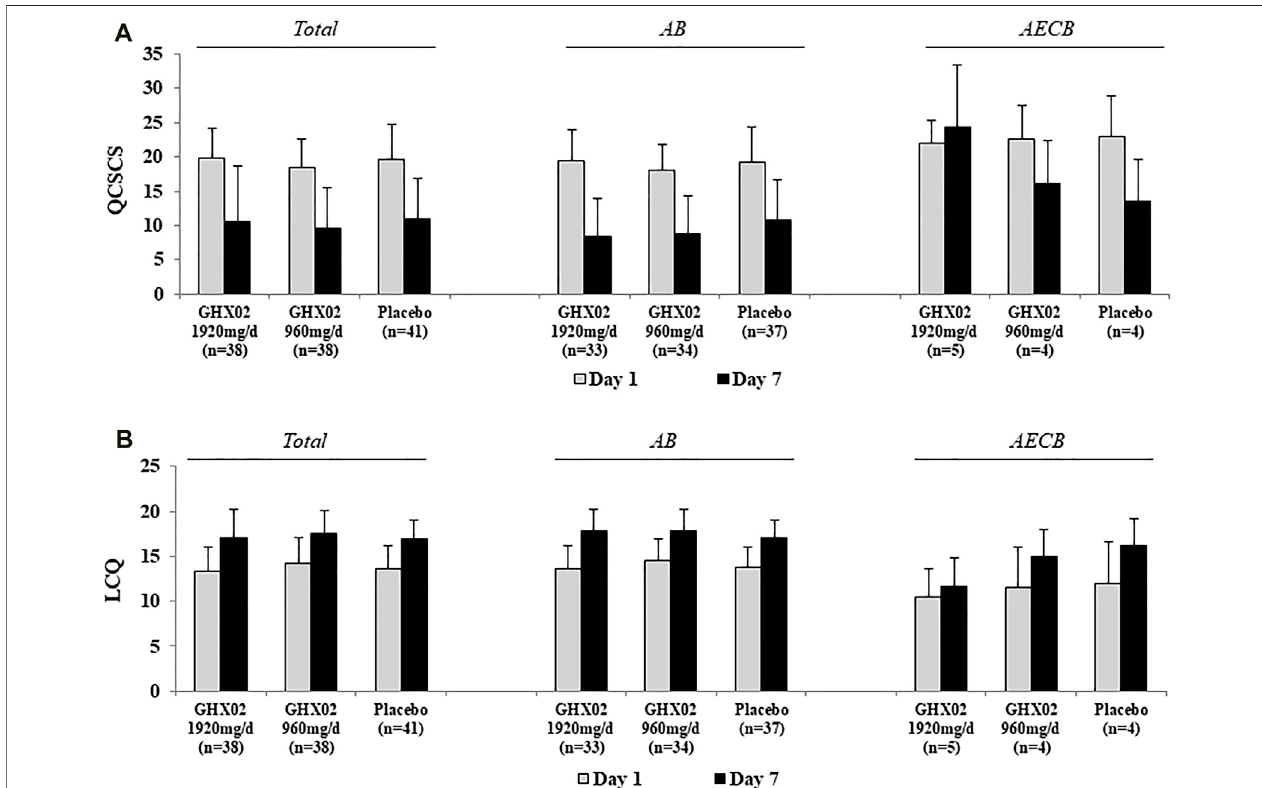
FIGURE 4 | Questionnaire of Clinical Symptoms of Cough and Sputum (QCSCS) and Leicester Cough Questionnaire (LCQ) from Day 1 to Day 7. (A) QCSCS (B) LCQ. Results are expressed as mean ± SD with 95% con fi dence intervals (CIs) in FAS analysis. p -values indicate signi fi cance of mean differences in the value between groups (* p < 0.05, ** p < 0.01, and *** p < 0.001). AB, Acute Bronchitis; AECB, Acute Exacerbations of Chronic